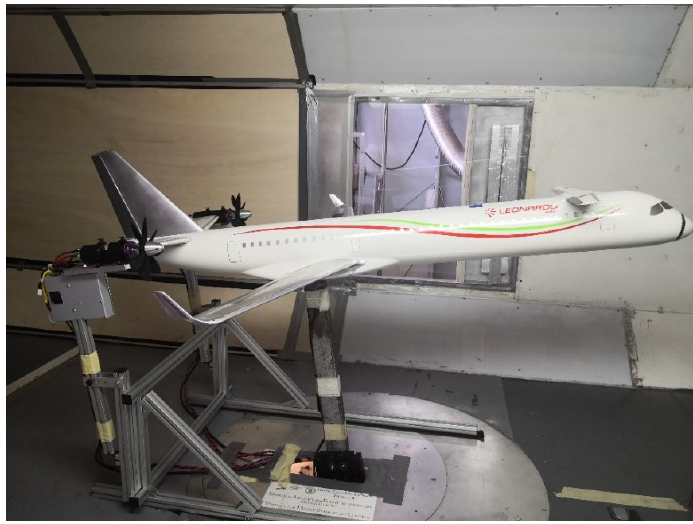
Figure 16. Aircraft complete configuration with electric